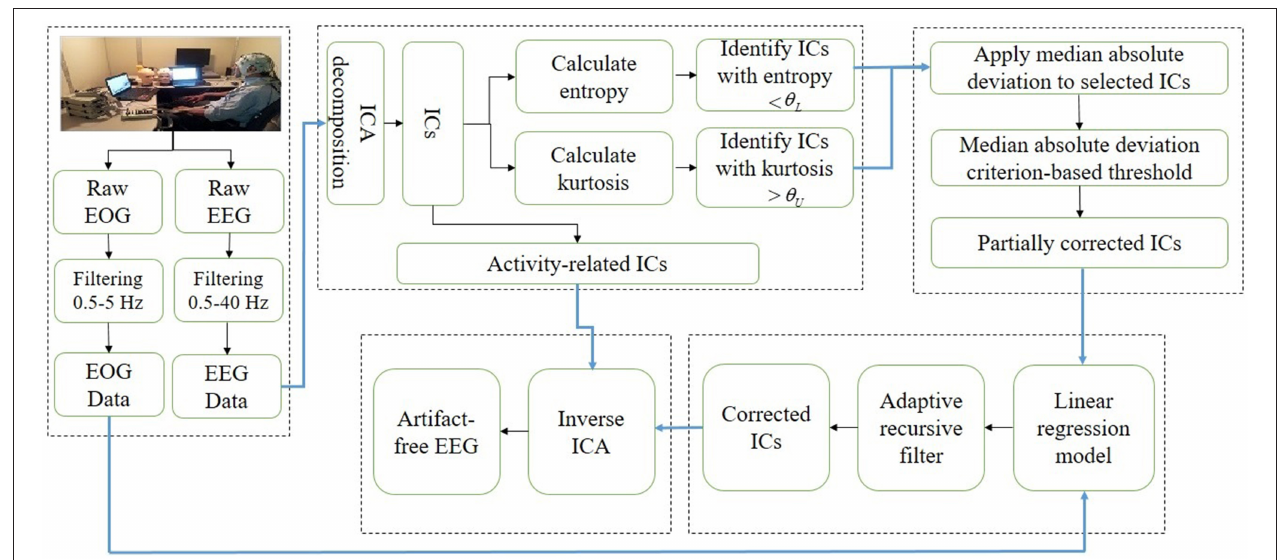
FIGURE 2 | Schematic diagram of the proposed